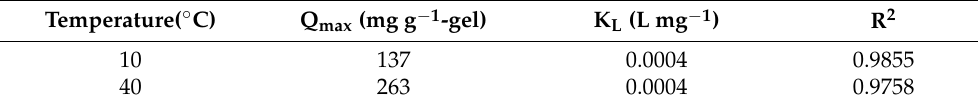
Table 2. Langmuir model parameters for the adsorption of As(III) in D-Cr gel.